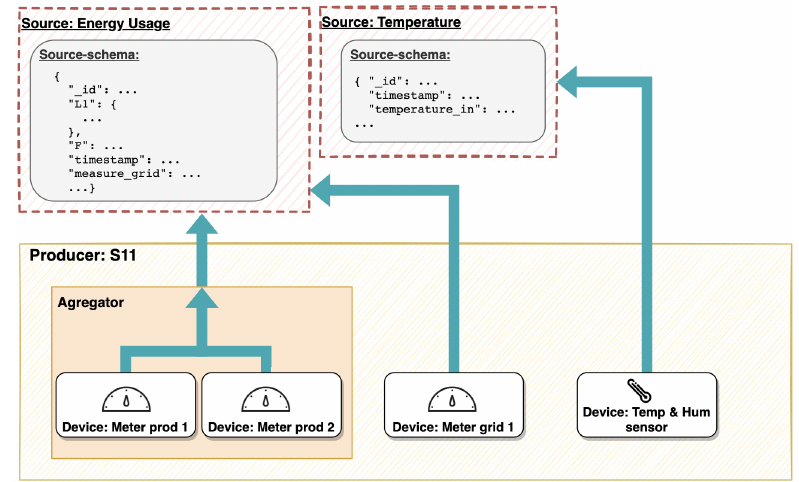
Figure 1. Relationship between the Producers, Sources and Schemas in the ESB, exemplified by the configuration used for